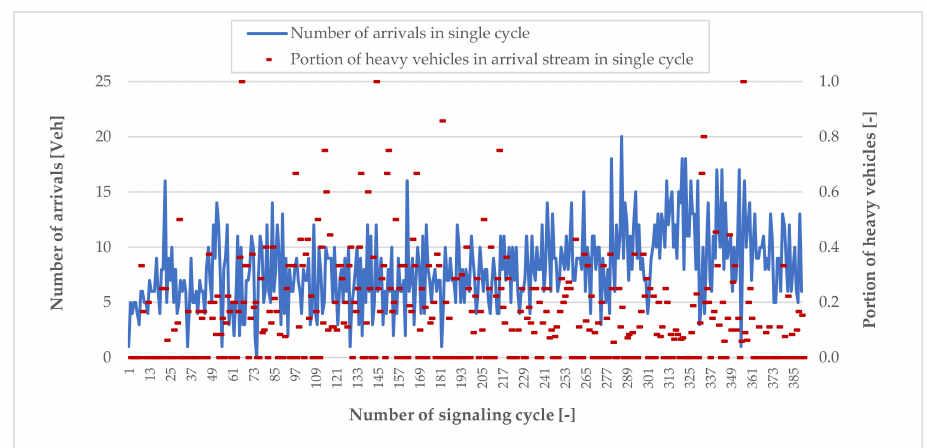
Figure 6. Distribution of the number of vehicles from the arrival stream in signaling cycles in a given measurement period taking into account the portion of heavy vehicles.